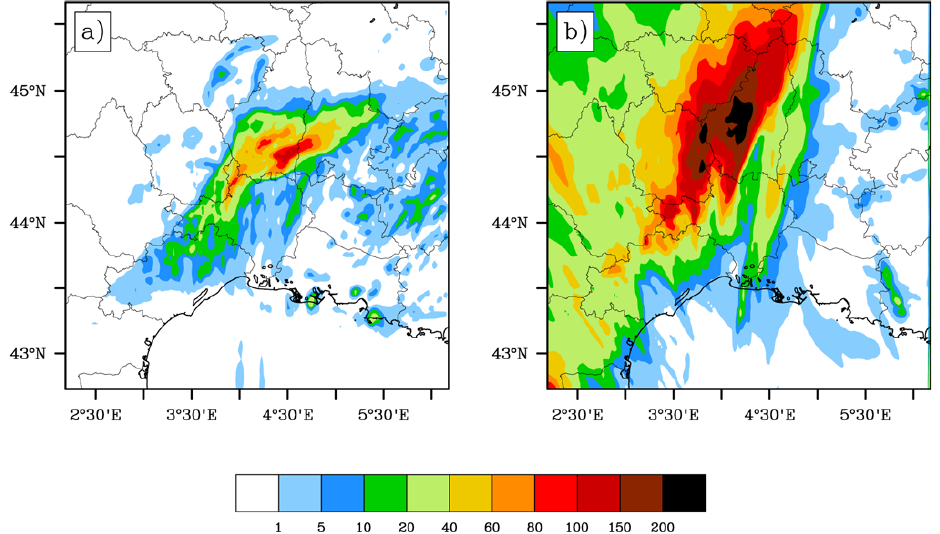
Fig. 4. 24h accumulated precipitation (in mm) from the reference simulations of the Gard-H´erault case from 20 October at 00:00UTC to 21 October at 00:00UTC (a) and for the C´evennes case from 1 November at 12:00UTC to 2 November at 12:00UTC (b)